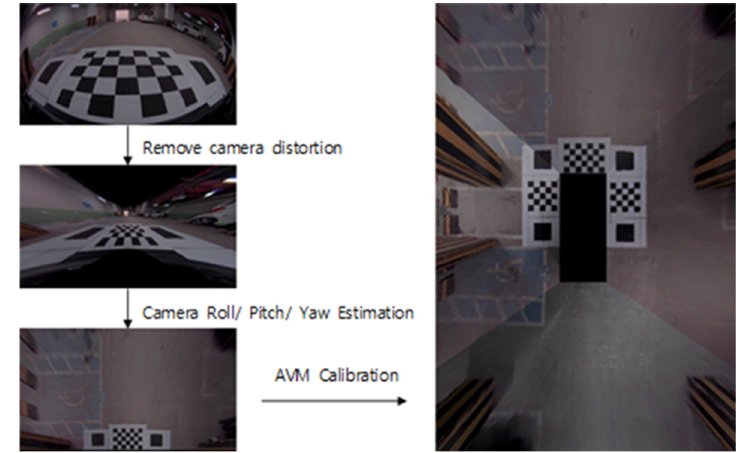
Figure 1. AVM calibration and registration.